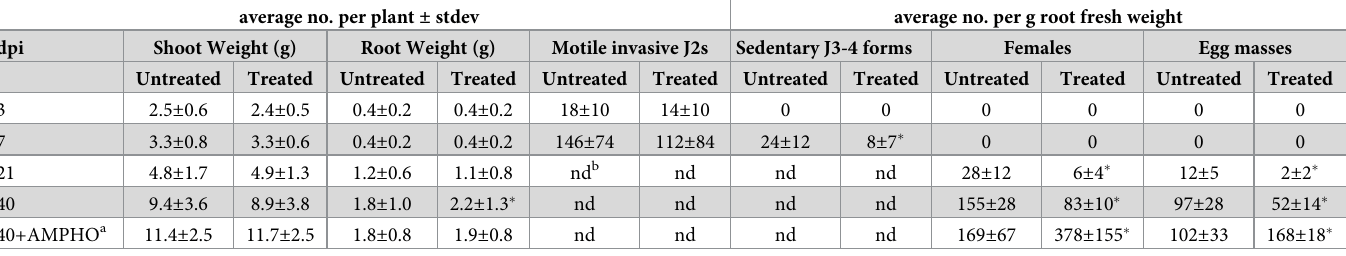
Table 2. Nematode individuals penetrated, developed and reproduced in roots of tomato plants untreated and treated with BCAs at different days after inoculation (dpi). average no. per plant ± stdev